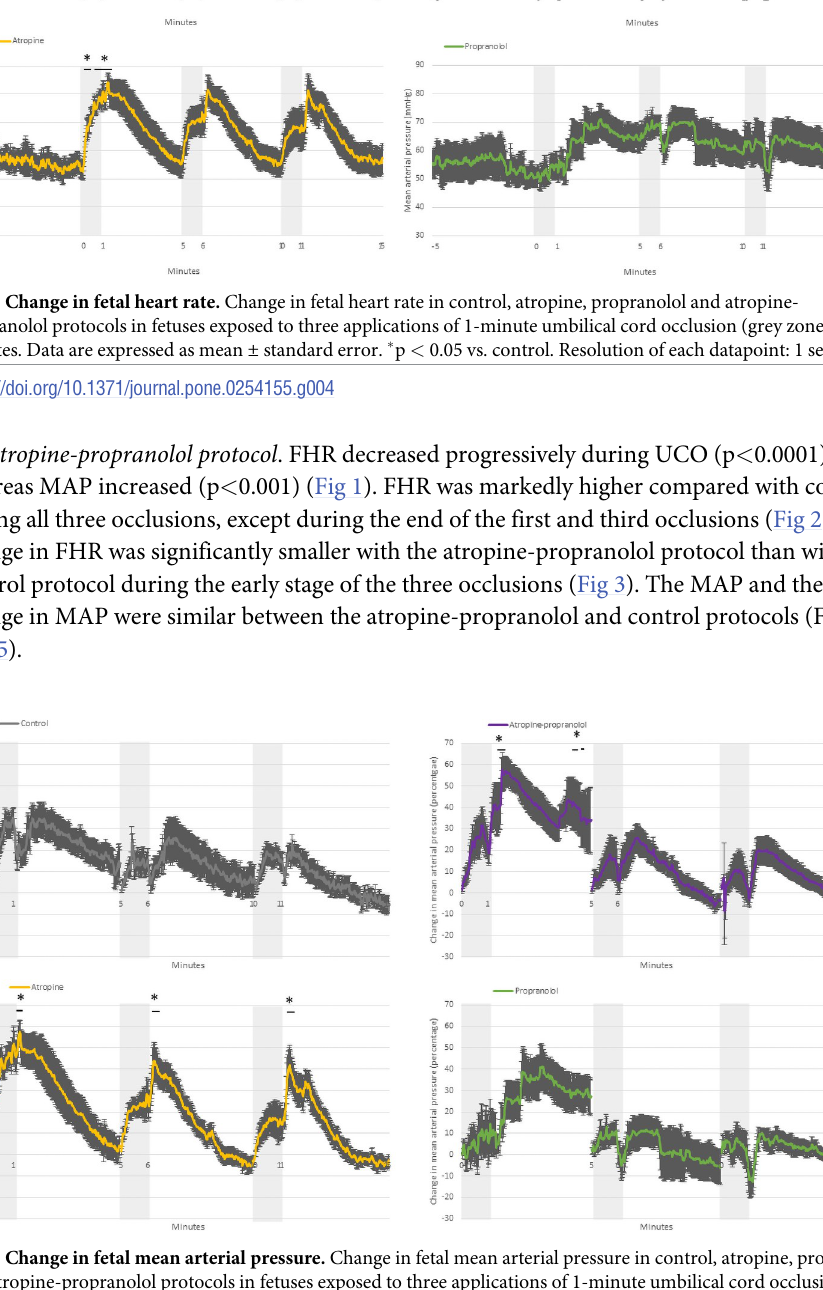
Fig 5. Change in fetal mean arterial pressure. Change in fetal mean arterial pressure in control, atropine, propranolol and atropine-propranolol protocols in fetuses exposed to three applications of 1-minute umbilical cord occlusion (grey zone) every 5 minutes. Data are expressed as mean ± standard error. � p < 0.05 vs. control. Resolution of each datapoint: 1 second.